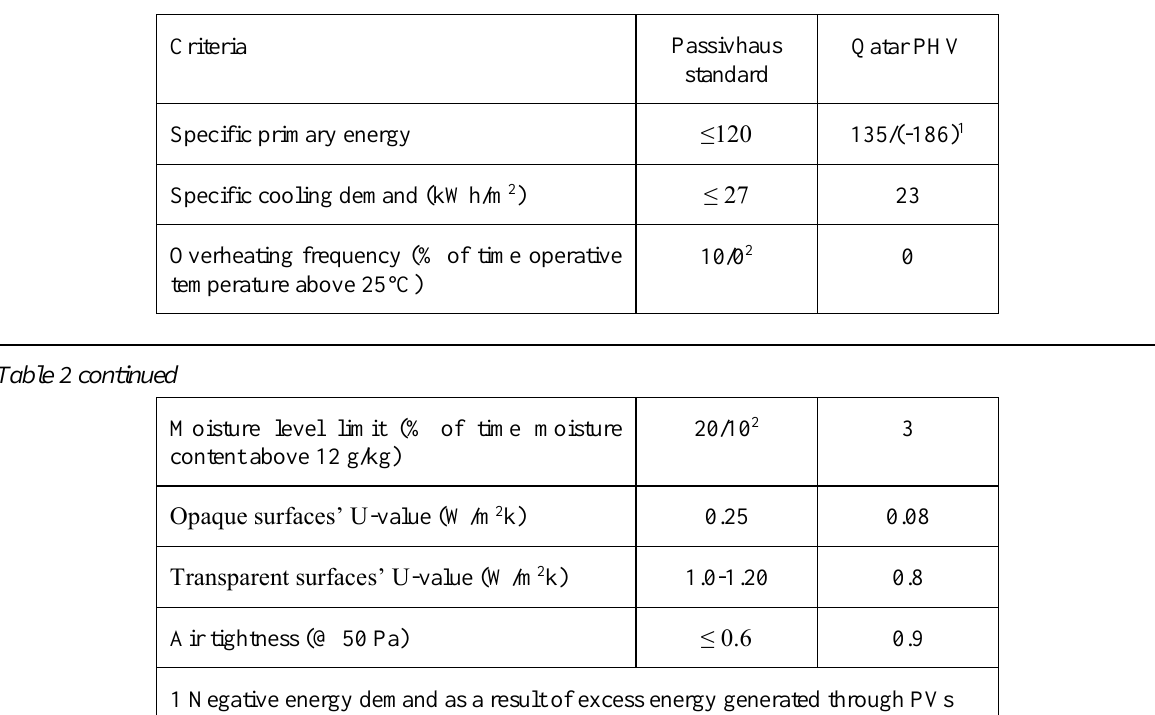
Table 1.Qatar Passivhaus villa vs. Passivhaus standards based on simulation